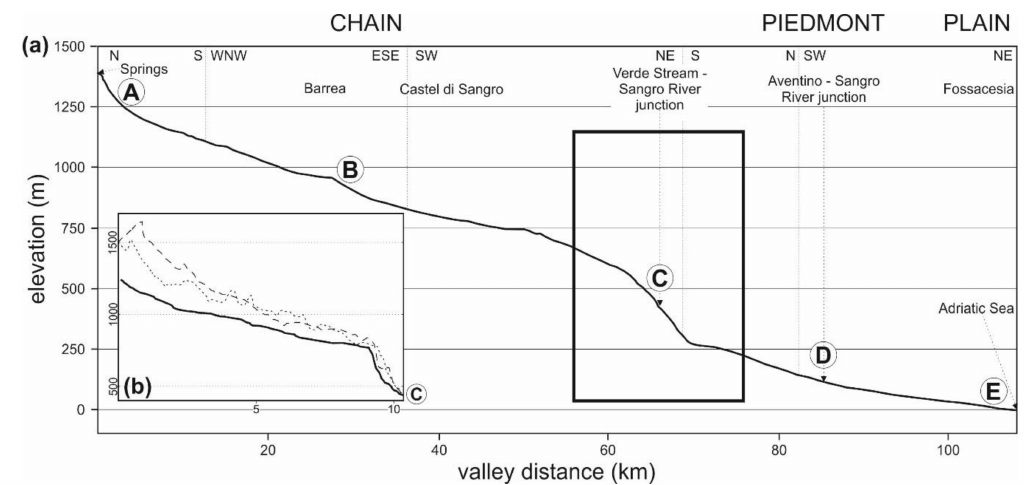
Figure 4. ( a ) Plot of the Sangro River’s long profile and location of the study area (box) (modified from [2]); ( b ) Plot of the Verde Stream’s long profile; stream profile is shown in black line; dotted line is the right side ridge-line profile; dashed line is left side ridge-profile. Location in Figure 1 (letters A, B, C, D,